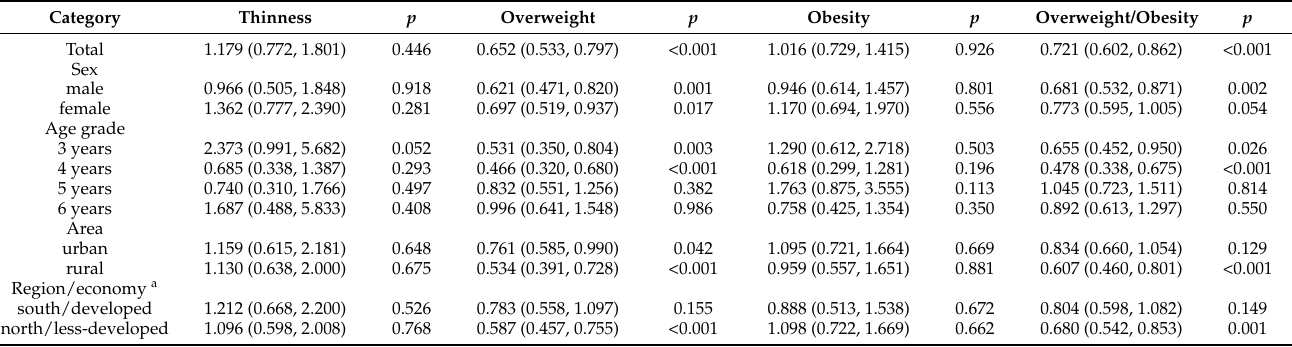
Table 3. Subgroup analysis of adjusted ORs (95% CI) of breastfeeding for thinness, overweight, and